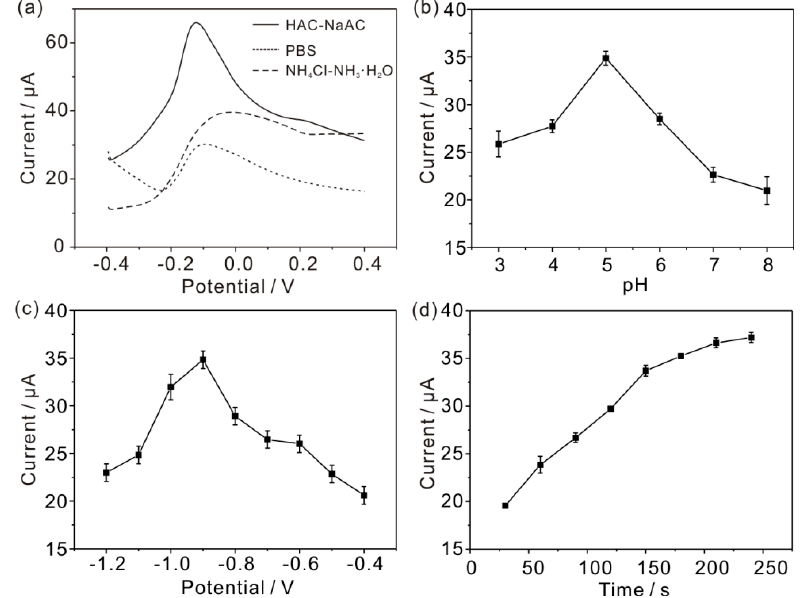
Figure 3. Influence of ( a ) supporting electrolytes; ( b ) pH value; ( c ) deposition potential; and ( d